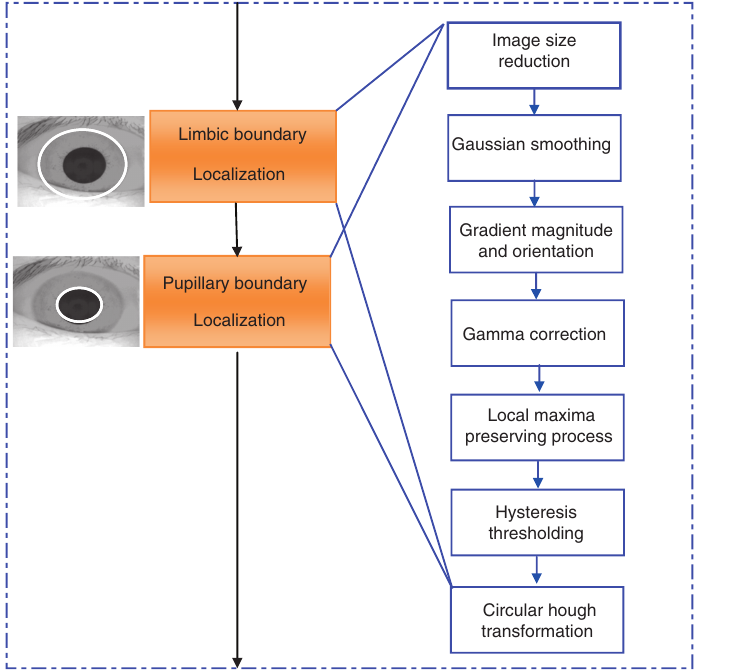
Figure 3. Flow Diagram of Algorithm A, which Uses the Edge Detection and Hough Transform to Localize Iris Boundaries (Limbic and Pupillary